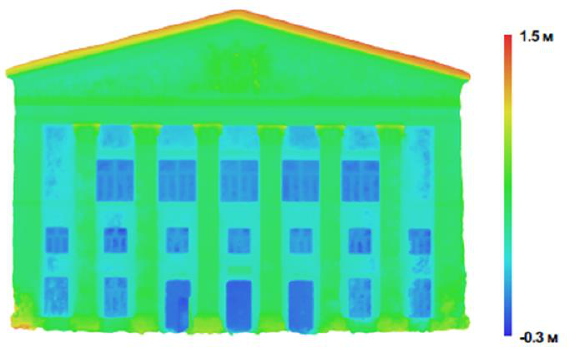
Figure 2. The three-dimensional façade model from point clouds